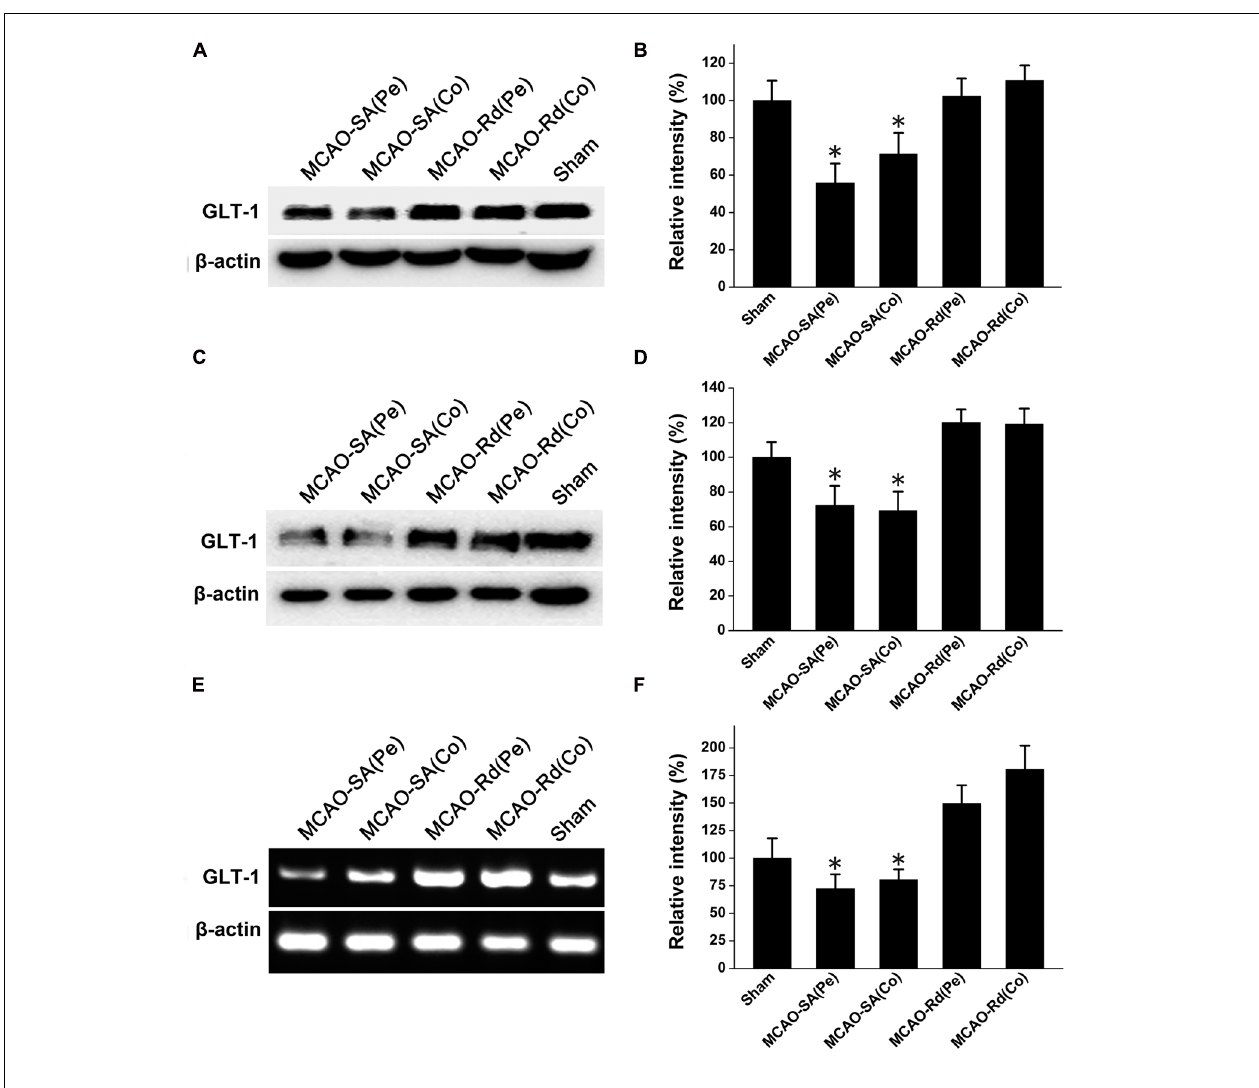
FIGURE 2 | Effect of Rd on GLT-1 expression in the core (Co) and penumbra (Pe) of ischemic brains. Western blotting analysis of GLT-1 expression at 4 h (A,B) and 24 h (C,D) following rat MCAO. (E,F) Analysis of